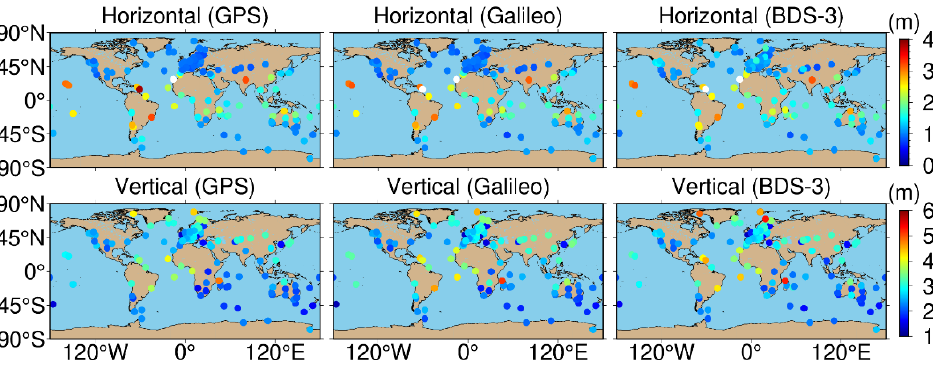
Figure 12. Geographical distribution of the dual-frequency positioning accuracy of 145 tracking stations in the horizontal and vertical sections of GPS, Galileo and BDS-3.